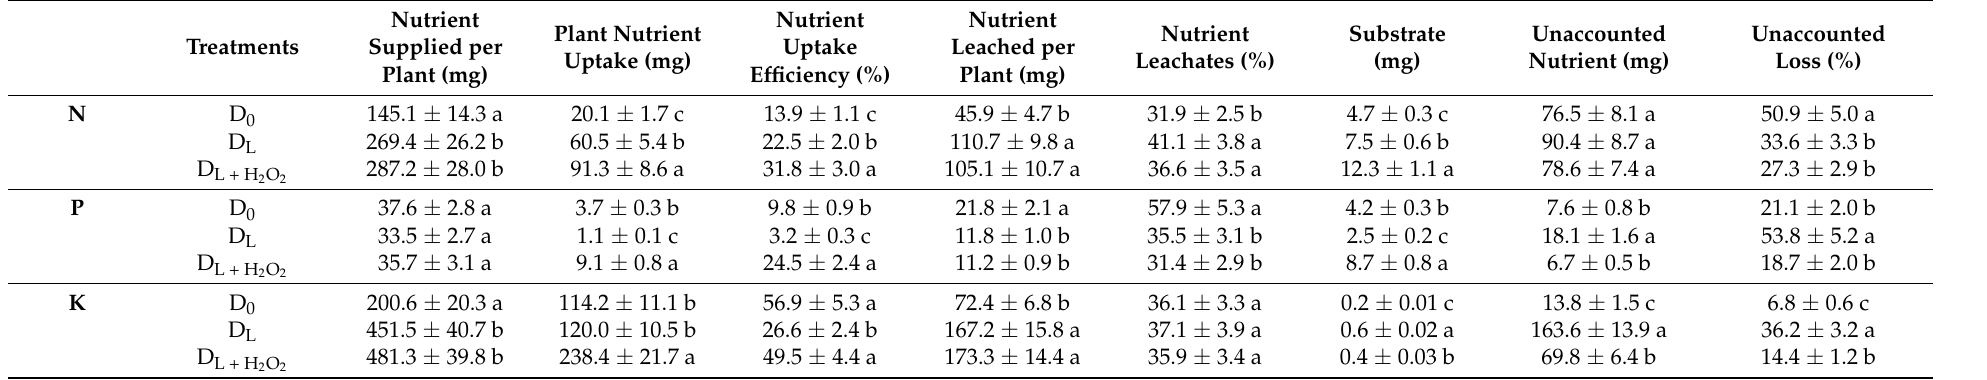
Table 6. Nutrient balance of D. deremensis plants under different fertigation treatments (D 0 —standard nutrient solution or control treatment, D L —raw leachate treatment and D L+H2O2 —raw leachate blended with H 2 O 2 treatment). The experiment simulates a cascade cropping system with different leachate treatments of Chrysalidocarpus lutescens as primary or “donor” and Dracaena deremensis as a secondary or “acceptor” plant culture. The results are expressed as means ± standard deviation ( n = 4). In each column, same letters indicate non-significant differences ( p <